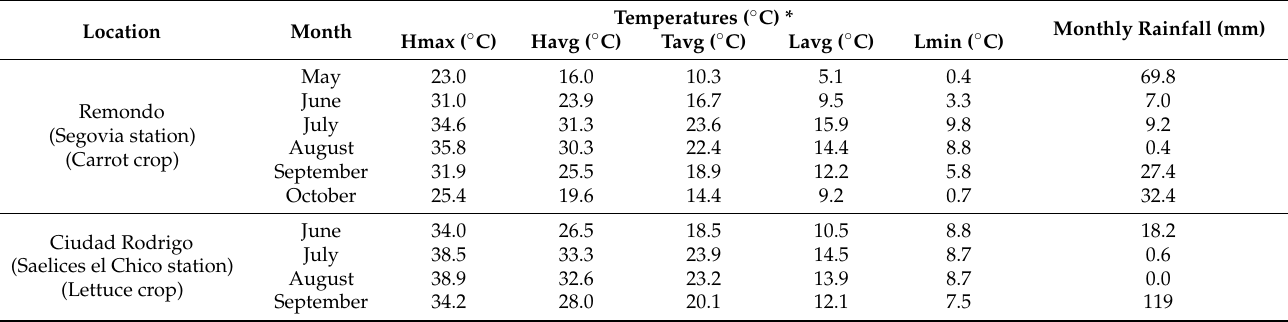
Table 2. Climatic conditions corresponding to the field experiments in the year 2013. The climatic data were recorded at the Segovia and Saelices el Chico (Salamanca) weather stations.